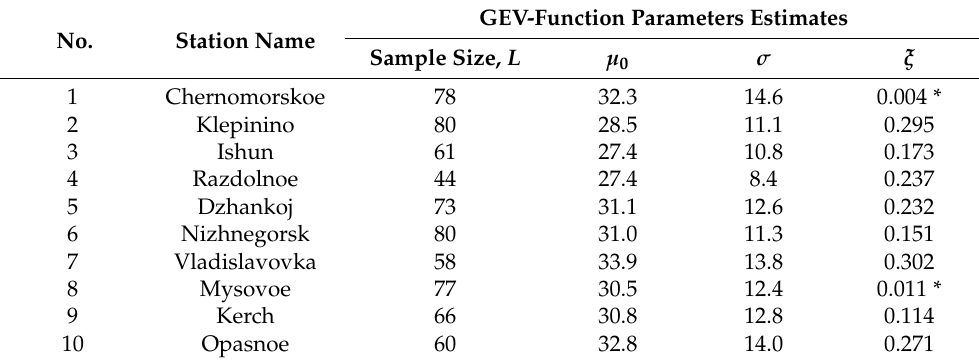
Figure 4. Spatial distribution of shape parameter ξ ( a ), theoretical curves of GEV exceedance prob- ability (F,%) for MADP (mm) ( b ), and interpolated MADP 100 ( c ) using data of 23 meteorological stations in Crimea for 1936–2020. The numbers of points and lines coincide with the numbering of the stations in Table 1. Table 3. GEV parameter estimates for annual maximum daily precipitation